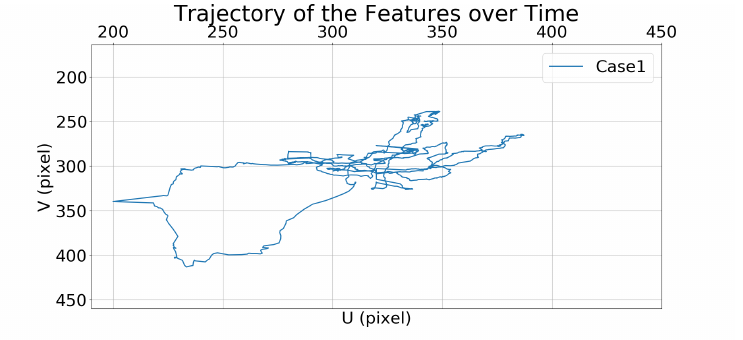
Figure 21. Case 1: trajectory of the moving target in the image frame using the IBVS controller. The performances quantified based on the RMS tracking errors are presented in Table